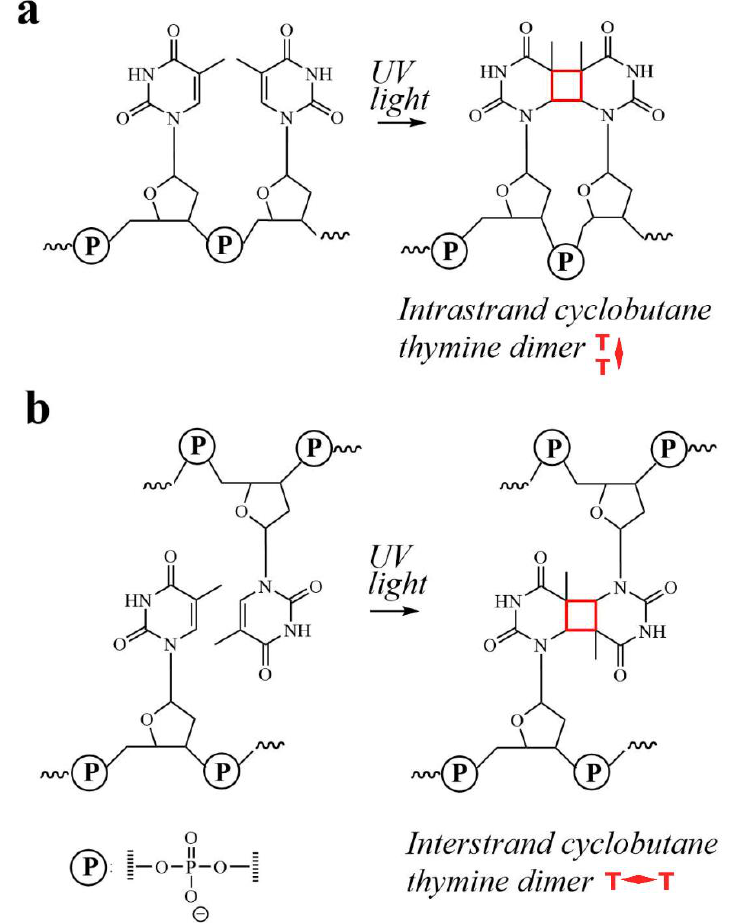
Figure 1. Photoinduced formation of a crosslink between thymines on DNA. ( a ) An intrastrand crosslink between adjacent thymines. ( b ) An interstrand crosslink between opposing thymines.